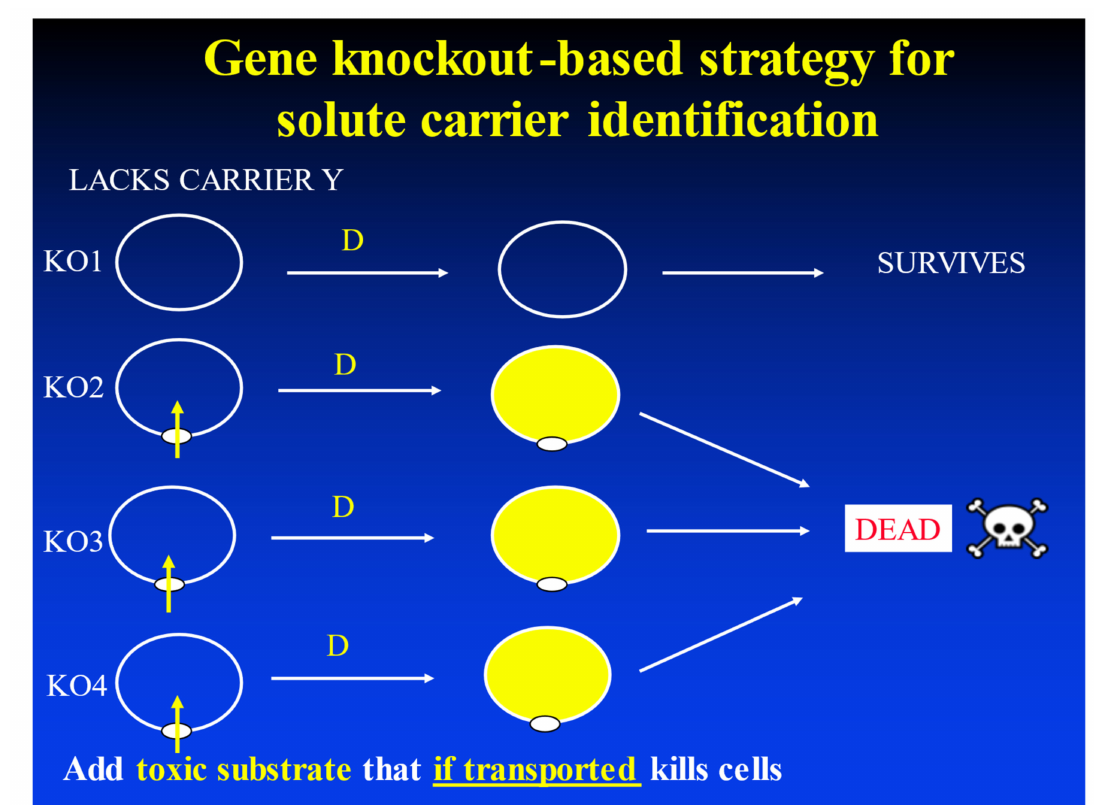
Figure 4. Principle of determining the substrate of a drug at toxic concentrations (e.g., [8,96,97,101,102]) by assessing the ability of cells lacking a particular transporter gene to survive its presence, while the wild-type cells, or cells knocked out for other genes not involved in the drug’s transport, are killed. Obviously, this is the extreme; there may also be degrees of